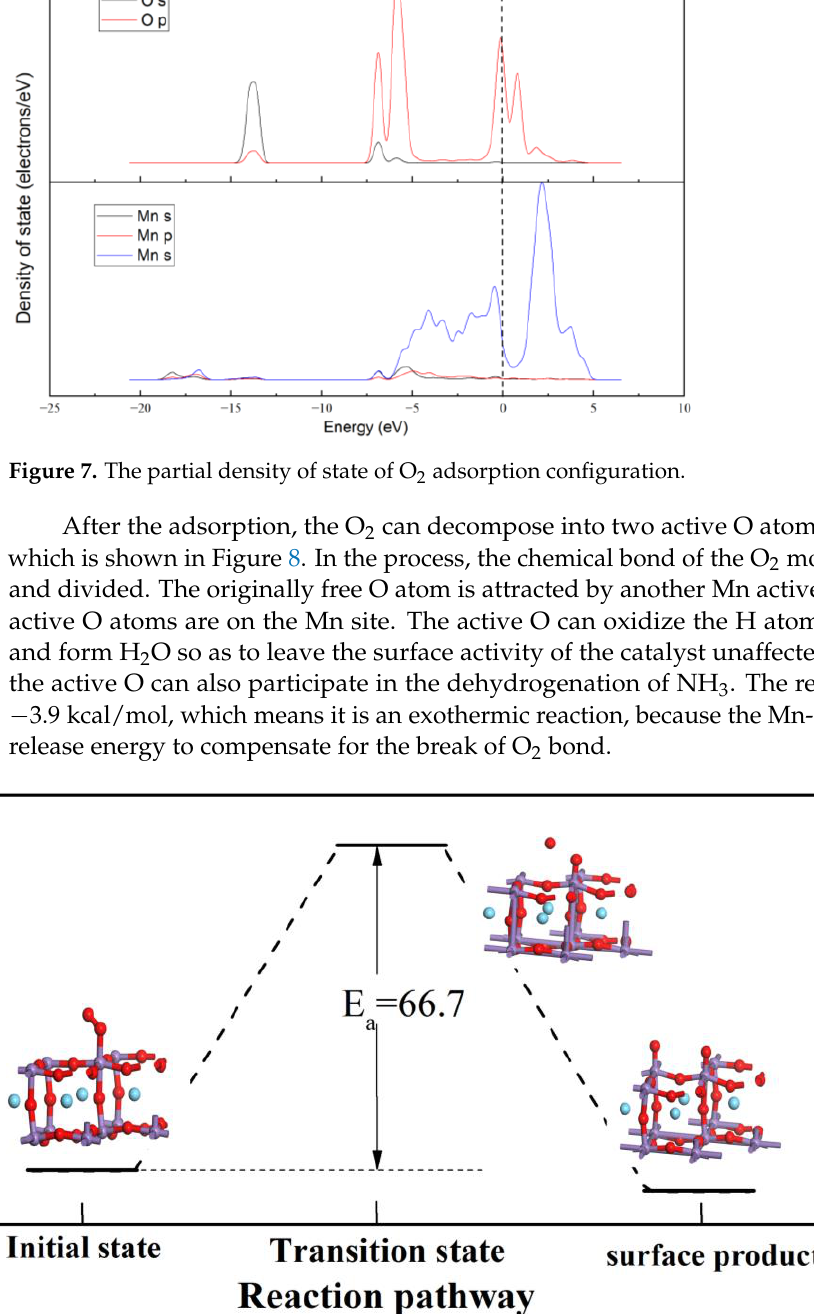
Figure 8. The decomposition process of O 2 on the LaMnO 3 surface.